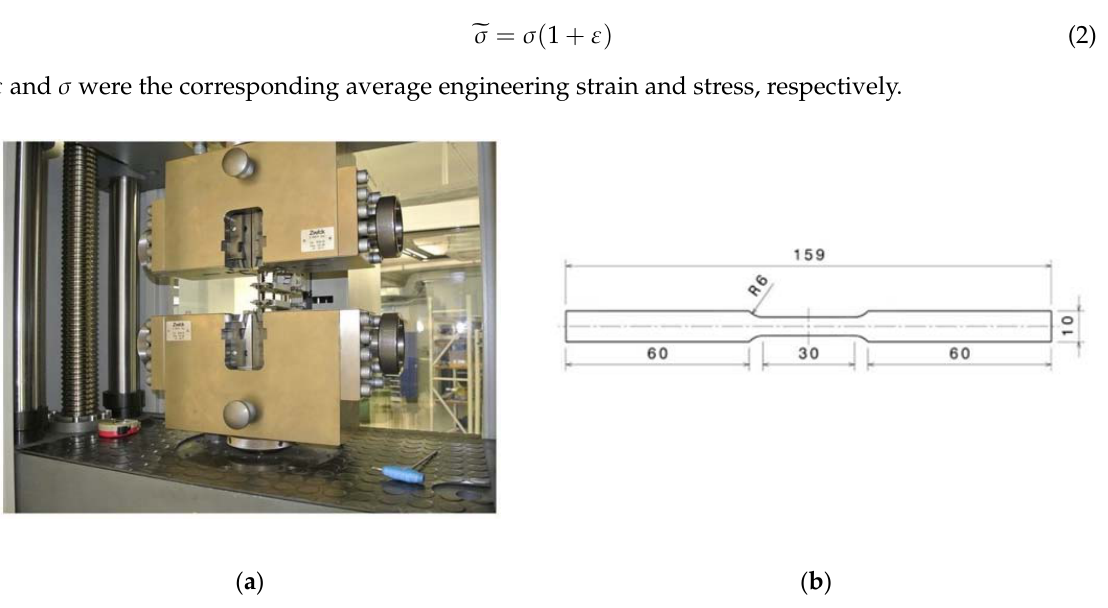
 and  were the corresponding average engineering strain and stress, respectively.